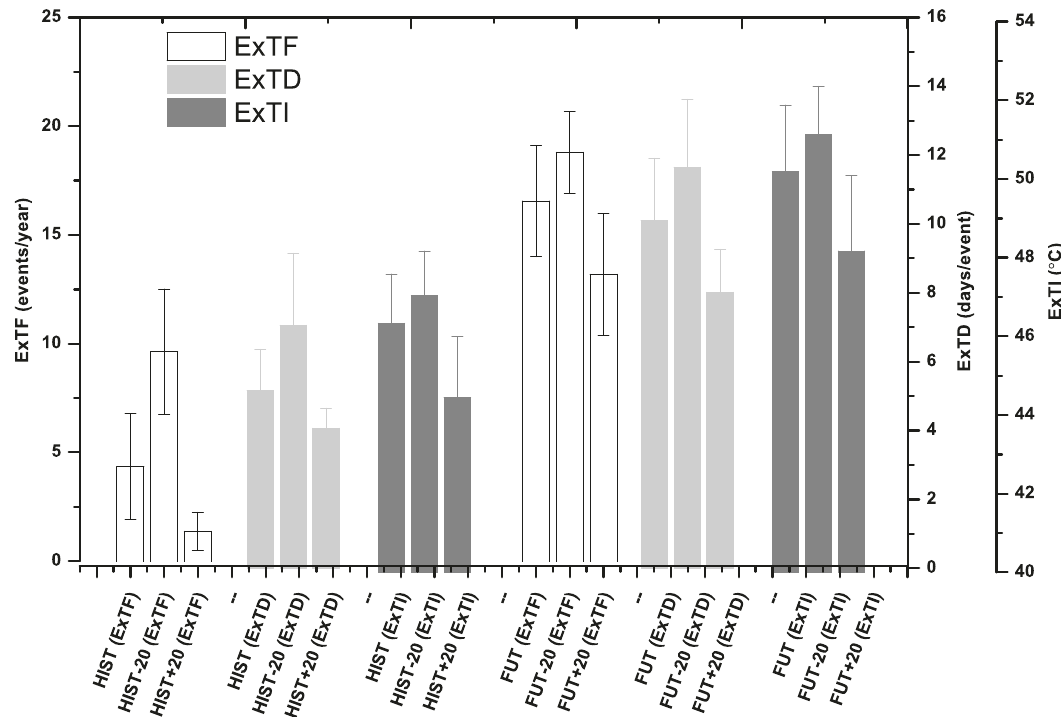
Fig. 7 Impact of SM on ExT over the NCI. Histogram compares the mean of ExTF (white), ExTD (light grey) and ExTI (dark grey) for six experiments i.e. HIST, HIST-20, HIST + 20, FUT, FUT-20 and FUT + 20, averaged over the NCI (75°E-87°E, 16°N-26°N, land only). Error bars in Figures indicate the standard deviation value of ExTF, ExTD and